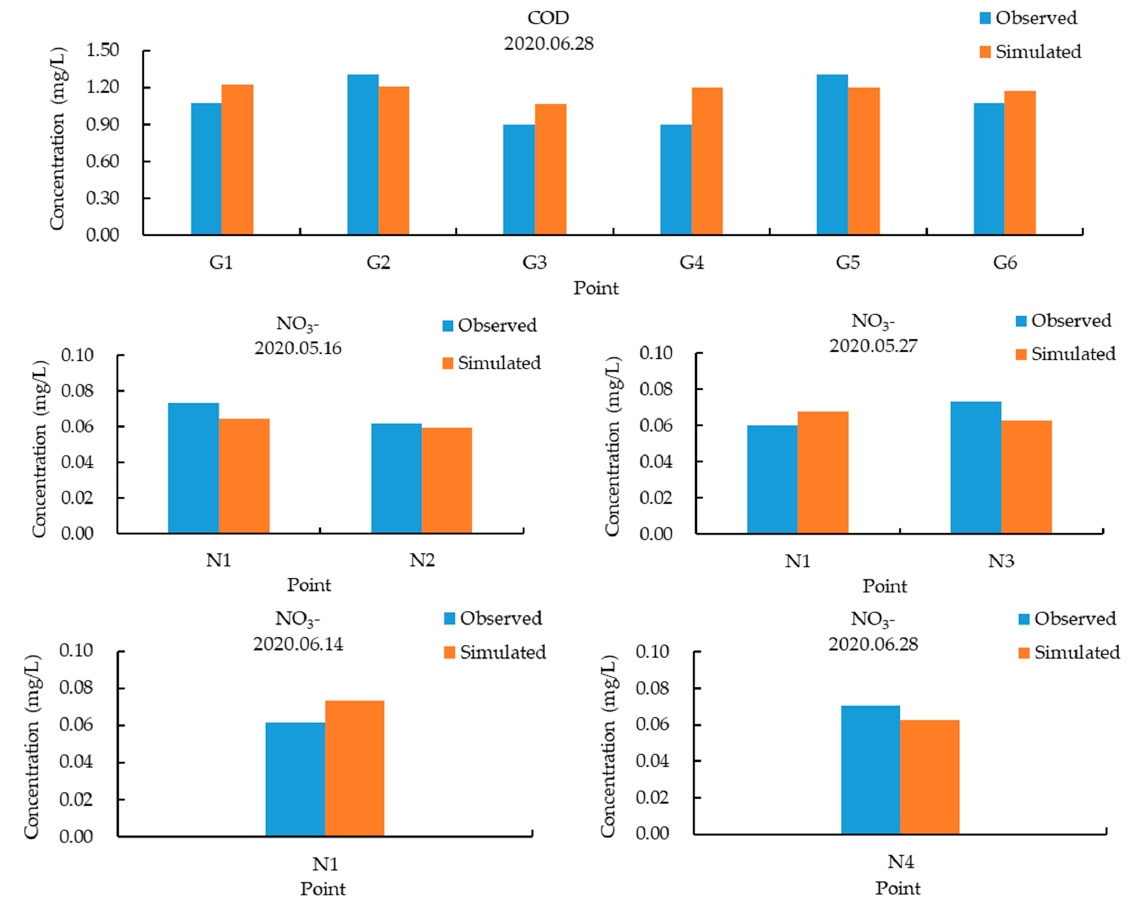
Figure 7. Validations of COD and NO 3 − based on the observed data in 2020.